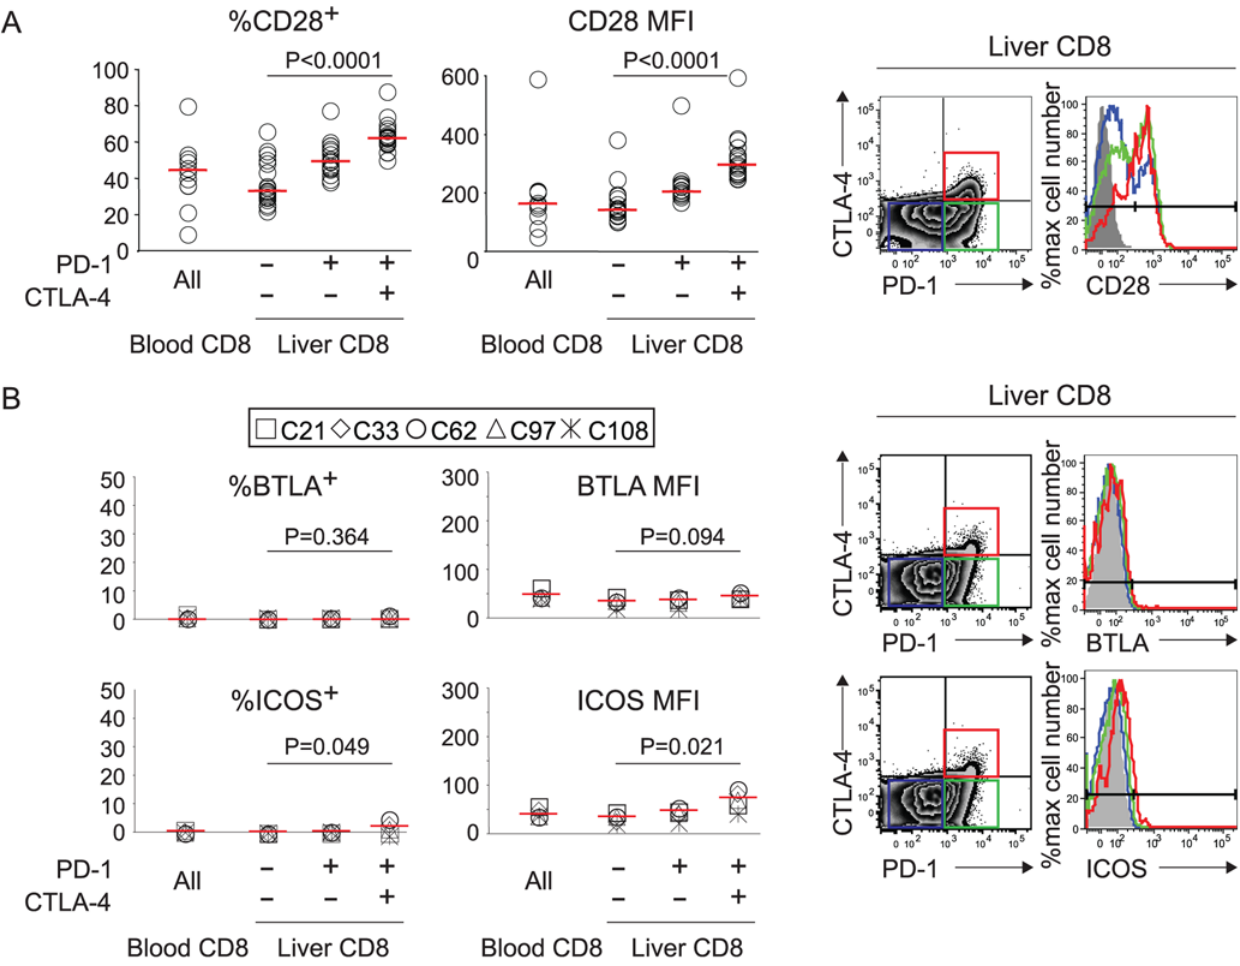
Figure 2. PD-1 + CTLA-4 + CD8 T cells from HCV-infected liver highly express CD28 but not ICOS or BTLA. (A) CD28 expression by percentage and MFI in total CD8 T cells from blood and in liver-derived CD8 T cell subsets (PD-1 2 CTLA-4 2 , PD-1 + CTLA-4 2 , PD-1 + CTLA-4 + ) ex vivo from 18 chronic HCV patients. Median values (red horizontal lines): %CD28 + in intrahepatic PD-1 2 CTLA-4 2 vs. PD-1 + CTLA-4 2 vs. PD-1 + CTLA-4 + subsets (33% vs. 49% vs. 62%, p , 0.0001 by the Kruskal Wallis test). (B) BTLA and ICOS expressions by percentage and MFI in total CD8 T cells from blood and in liver-derived CD8 T cell subsets (PD-1 2 CTLA-4 2 , PD-1 + CTLA-4 2 , PD-1 + CTLA-4 + ) ex vivo from 5 chronic HCV patients. Median values (red horizontal lines): %BTLA + (intrahepatic CD8 subsets: 0.1% vs. 0.4% vs. 0.3%, p=0.364); %ICOS + (intrahepatic CD8 subsets: 0.1% vs. 0.5% vs. 2.4%, p=0.049); ICOS MFI (intrahepatic CD8 subsets: 43 vs. 50 vs. 78, p=0.021). The p-values were calculated by the Kruskal Wallis test. Flow cytometry plots on the right show the characteristic PD-1 and CTLA-4 expression in intrahepatic CD8 T cells (left) and the relative CD28, BTLA and ICOS expression in PD-1 + CTLA- 4 + (Red), PD-1 + CTLA-4 2 (Green) and PD-1 2 CTLA-4 2 (Blue) CD8 T cell subsets relative to isotype control (gray shade) in the histograms on the right.